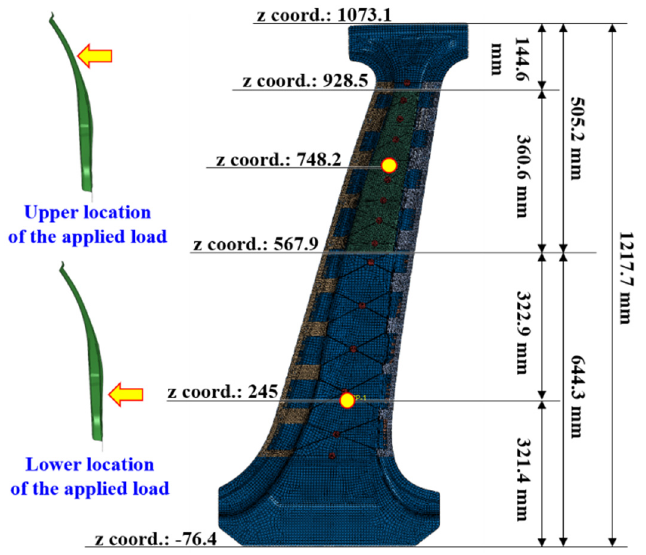
Figure 14. Position of the upper and lower bending loads applied to the center pillar analysis model.